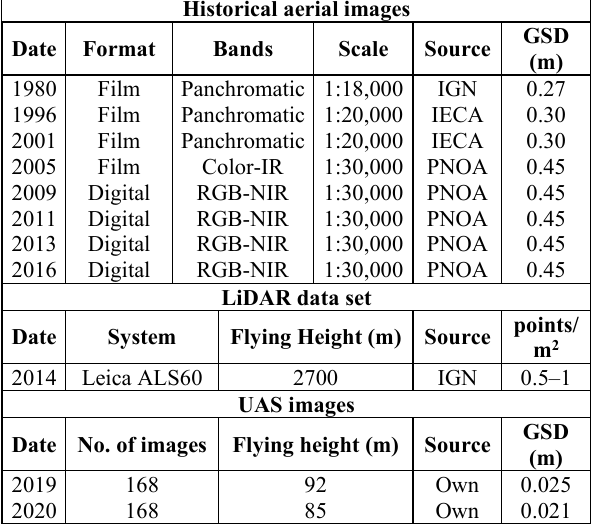
Table 1. Properties of datasets and